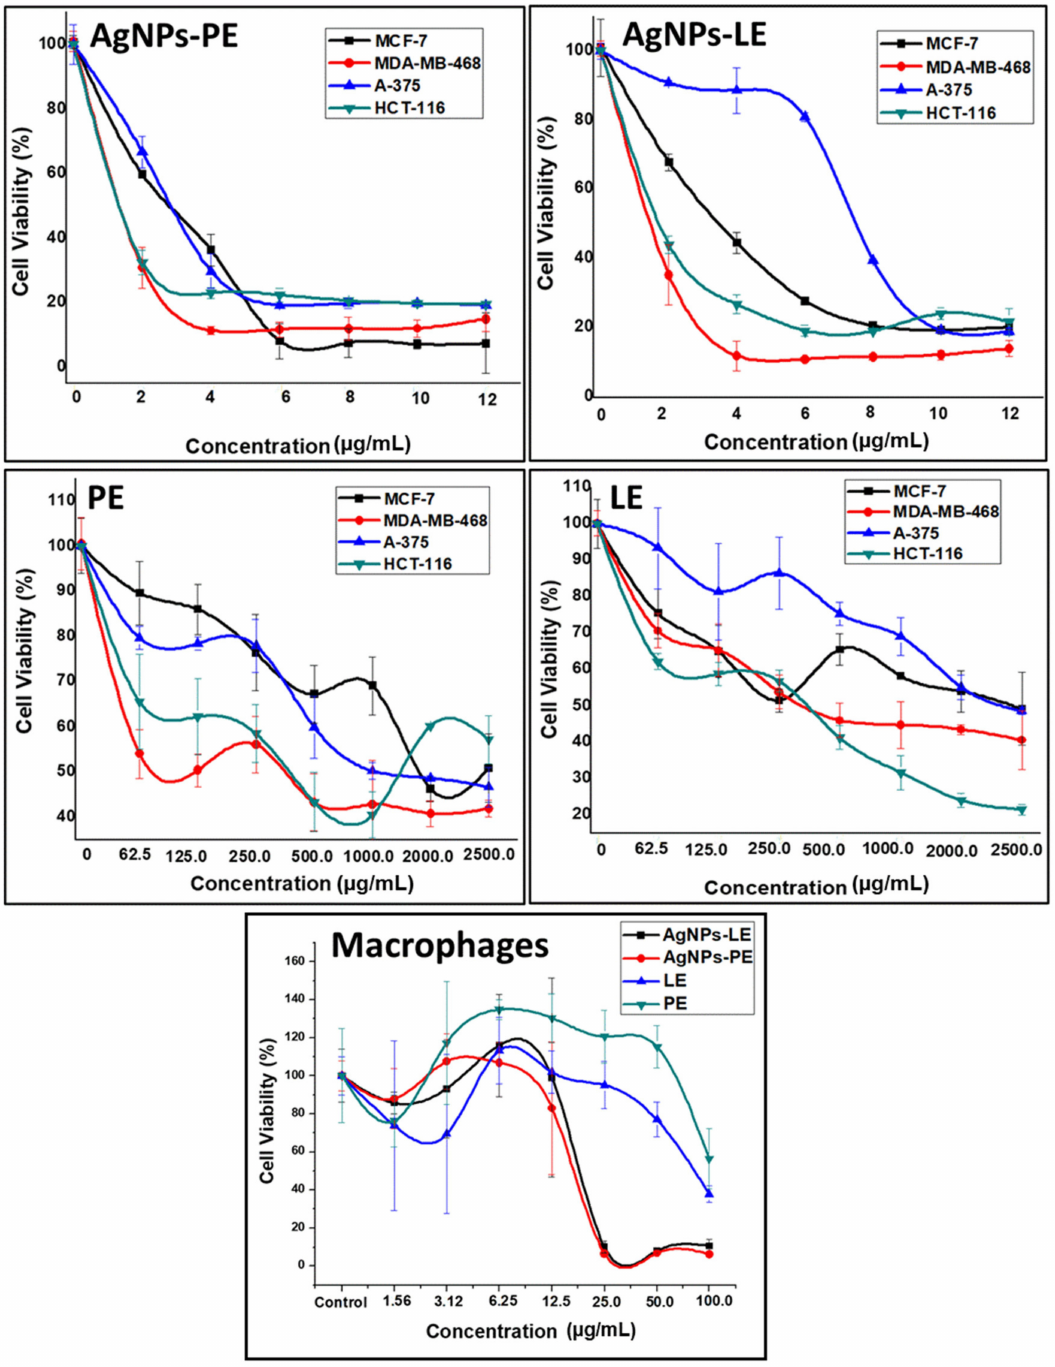
Figure 5. Graphs of the percentage of cell viability with respect to different concentrations of LE, PE, AgNPs-LE and